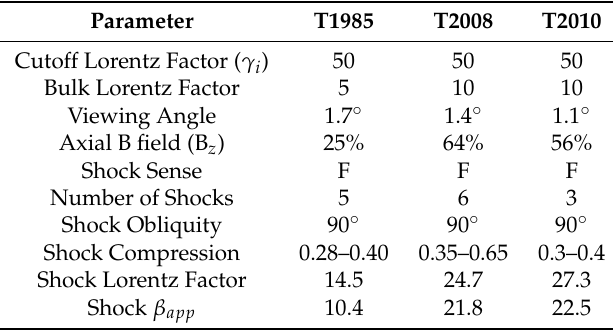
Figure 4. ( Left ): The observed light curves during T2008. Upwards arrows along the abscissa mark the adopted shock onsets; ( Right ): The simulated light curves using the adopted parameters listed in Table 3. Table 3. OT 081 flow parameters and shock